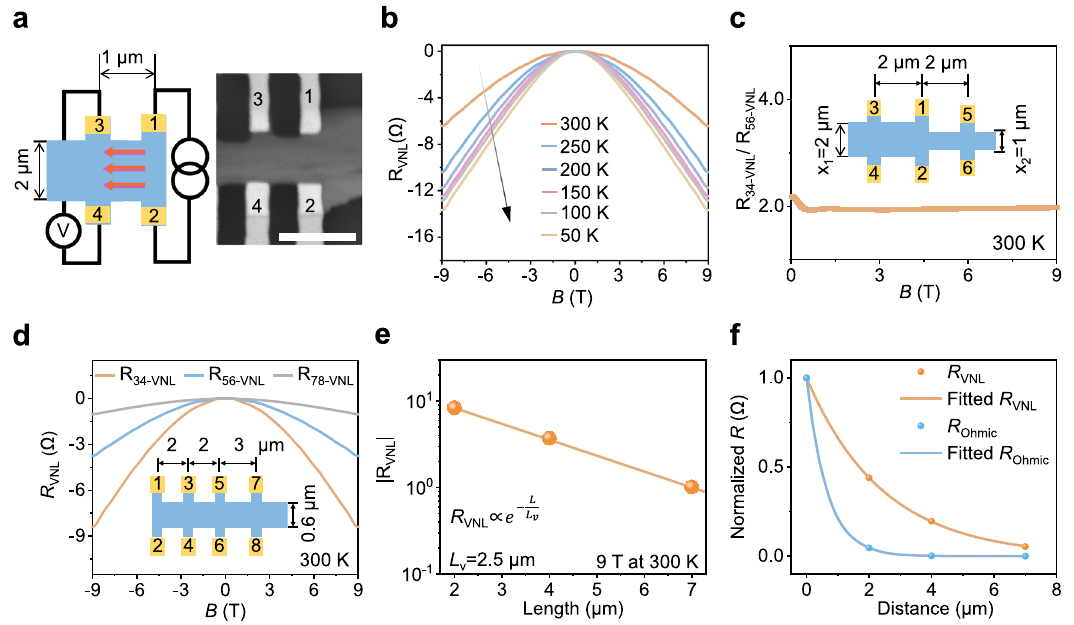
Fig. 2 | Temperature-, width- and length-dependent valley transport char- acteristics. a Schematic and scanning electron microscopy image of the “ H ” geo- metryTevalleydevice.Afterapplyingtheconstantcurrent I d throughterminal1 – 2, imbalanced valley (red arrow) propagates to the detection terminal 3 – 4. The scale bar is 3 μ m. b Temperature-dependent valley transport from 50 to 300K. Valley non-local resistance ( R VNL ) decreases as the temperature increases. c The ratio of non-local valley resistances under different widths. R 34-VNL and R 56-VNL are corre- sponding to the non-local valley resistance from terminals 3 – 4 and 5 – 6, respec- tively. Inset is the schematic of width-dependent valley device with width of